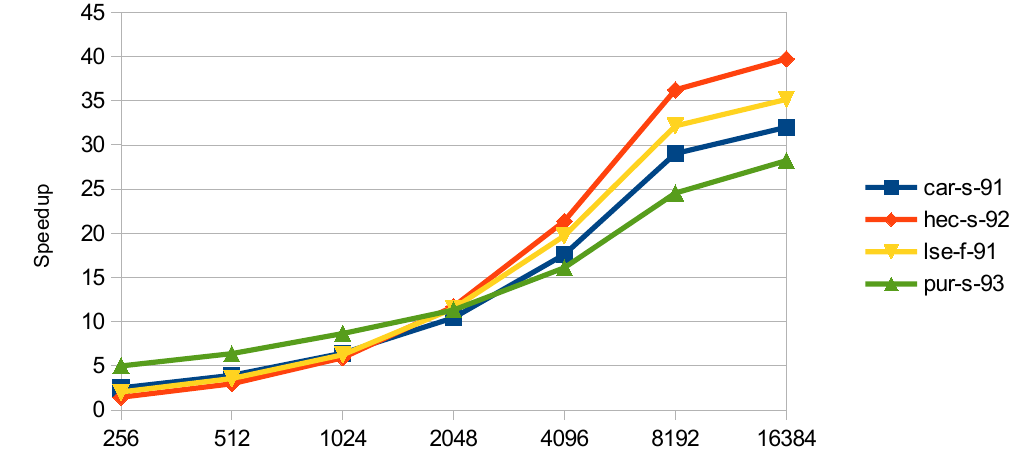
Figure 5. Speedup in the reproduction stage for the examination-threaded approach with the separation of the selection and reproduction stages in different